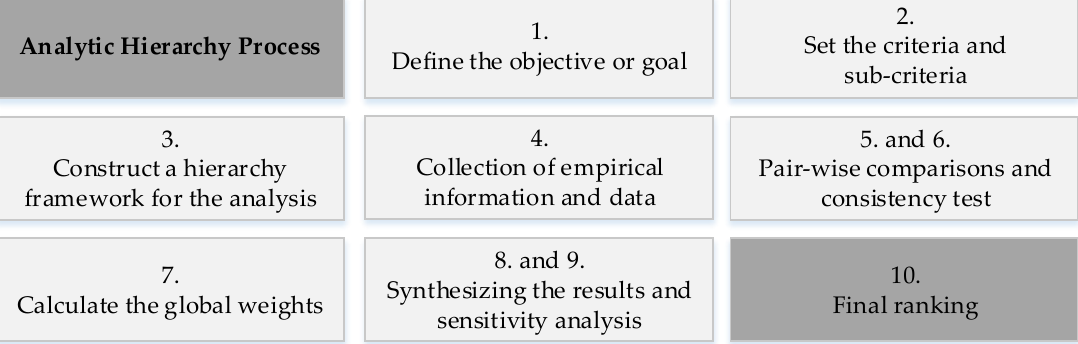
Figure 1. Steps in analytic hierarchy process (AHP) study.